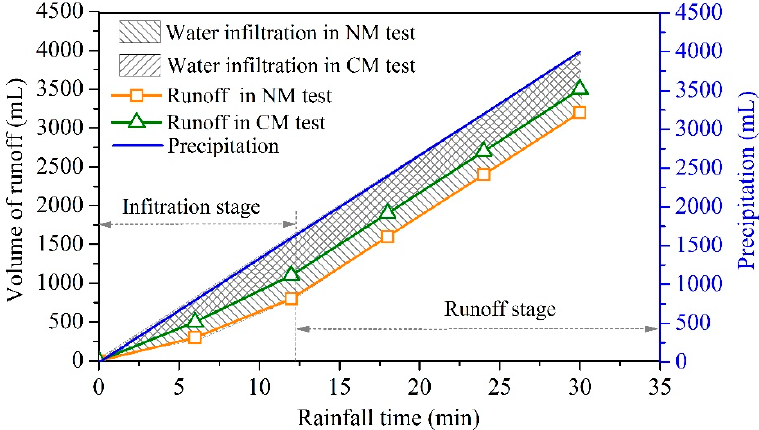
Figure 10. Relationship between the runoff volume, cumulative precipitation, and rainfall time.